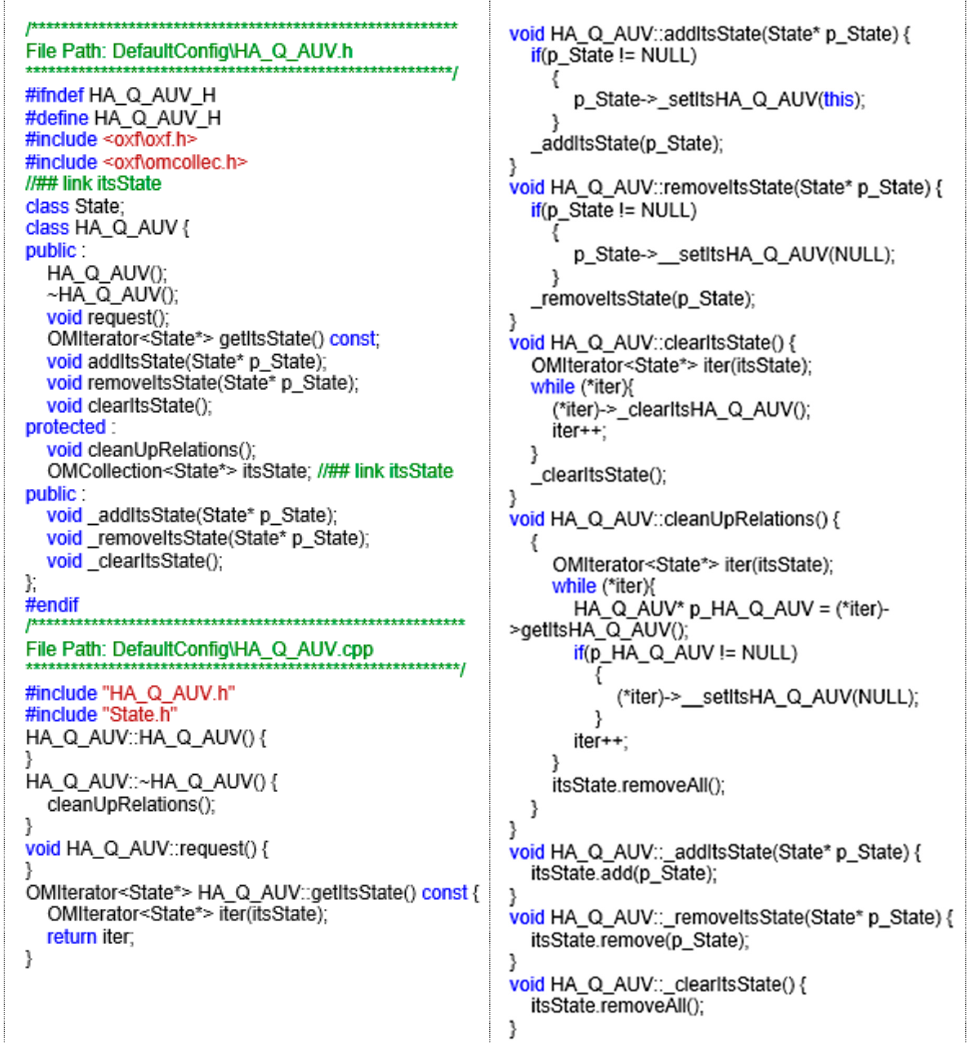
Figure A1. Appl. Sci. 2020 , 10 , x FOR PEER REVIEW